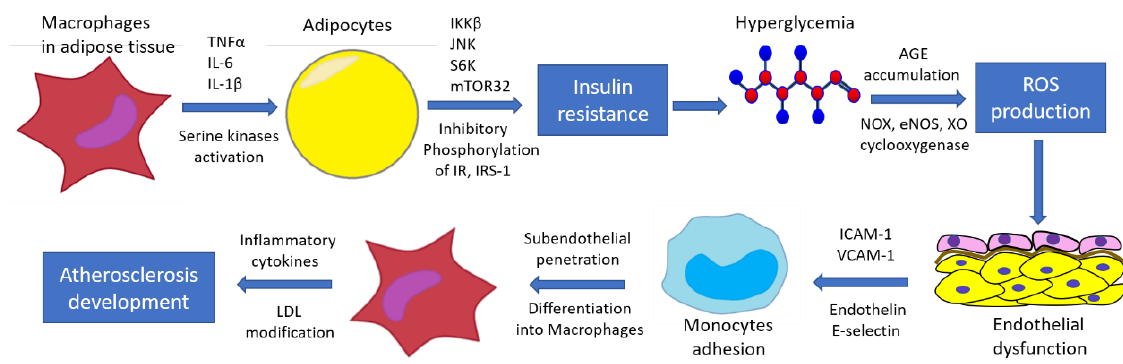
Figure 2. Mechanisms of atherosclerosis development in diabetes.